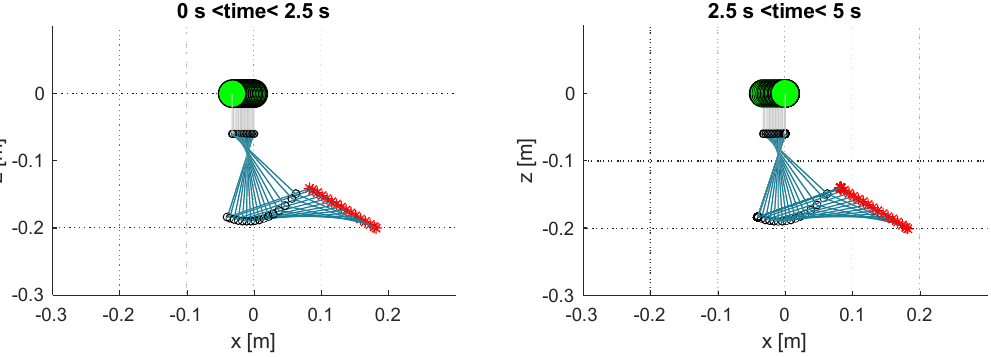
Figure 6. Stroboscopic trajectories for the first half ( left ) and second half ( right ) of the linear trajectory task for the 2-DOF trolley model and ideal control assumption. The UAV base is the large green marker, joints are the black circles, links are the blue lines, and end-effector positions tracked are the red crosses.